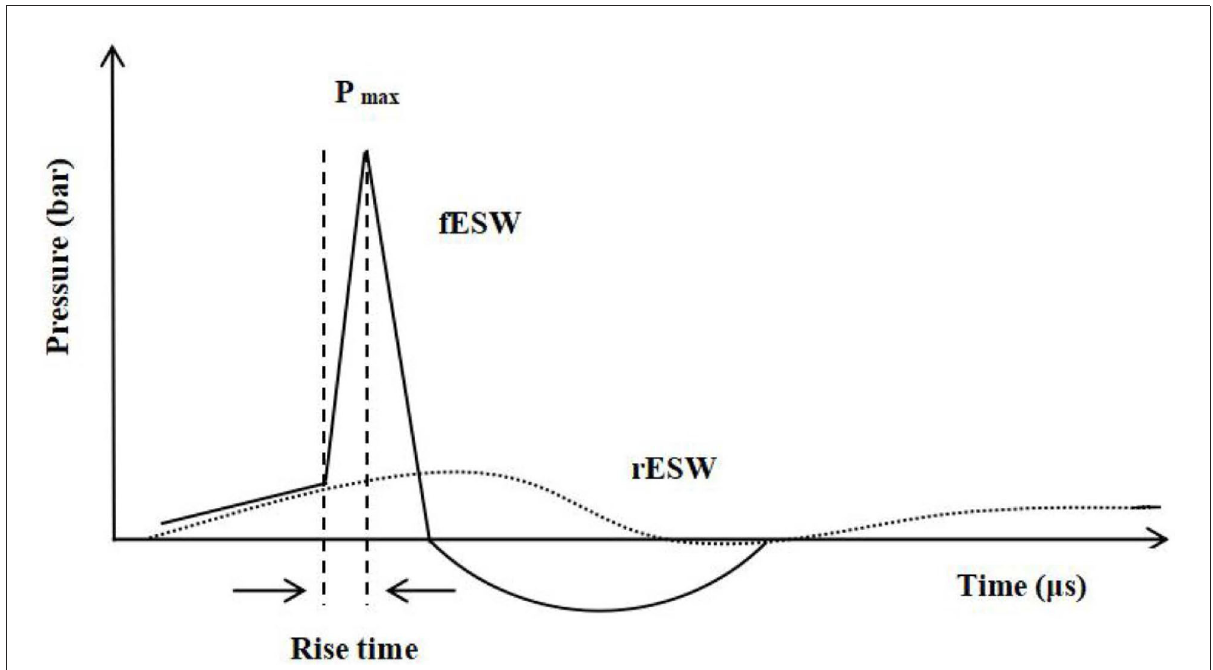
FIGURE1 —Waveform characteristics of shock wave (fESW): a short rise time, high peak pressure, and non-linearity. Pmax, Pressure maximum. ...Waveform characteristics of pressure wave